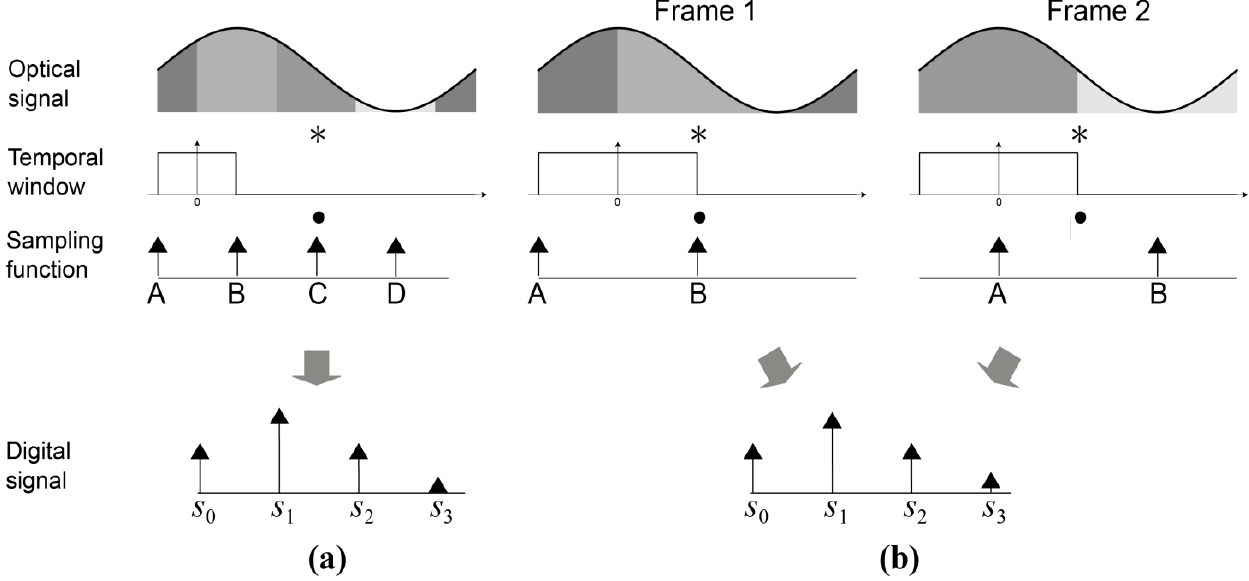
Figure 11. iTOF sampling for a 4 tap pixel ( a ) and a pseudo 4 tap pixel using 2 tap pixel ( b ) . The * sign denotes the convolution in Equation (5).